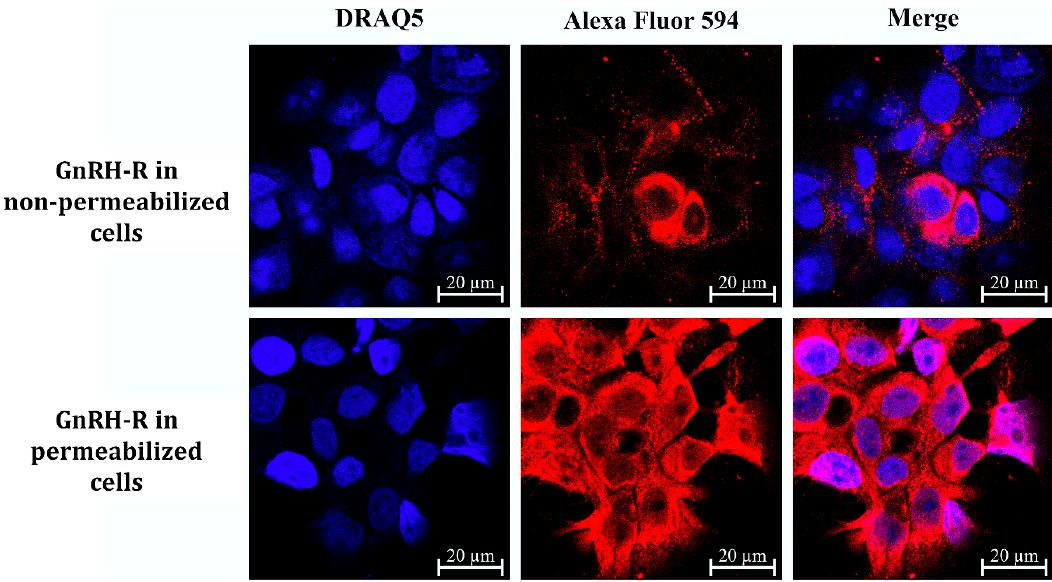
Figure 5. GnRH-R in Detroit-562 cells. The measurements confirm the high GnRH-R expression